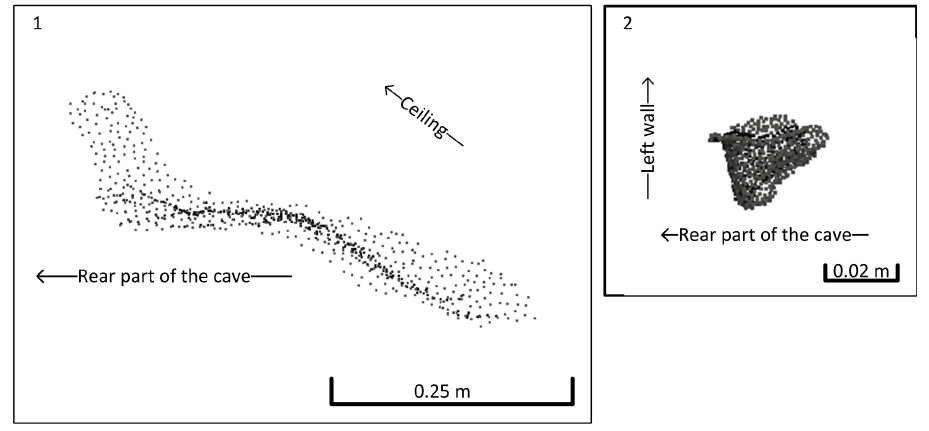
Figure 6. Morphological characterisation of extracted details 1 and 2, which are marked in Fig. (5).